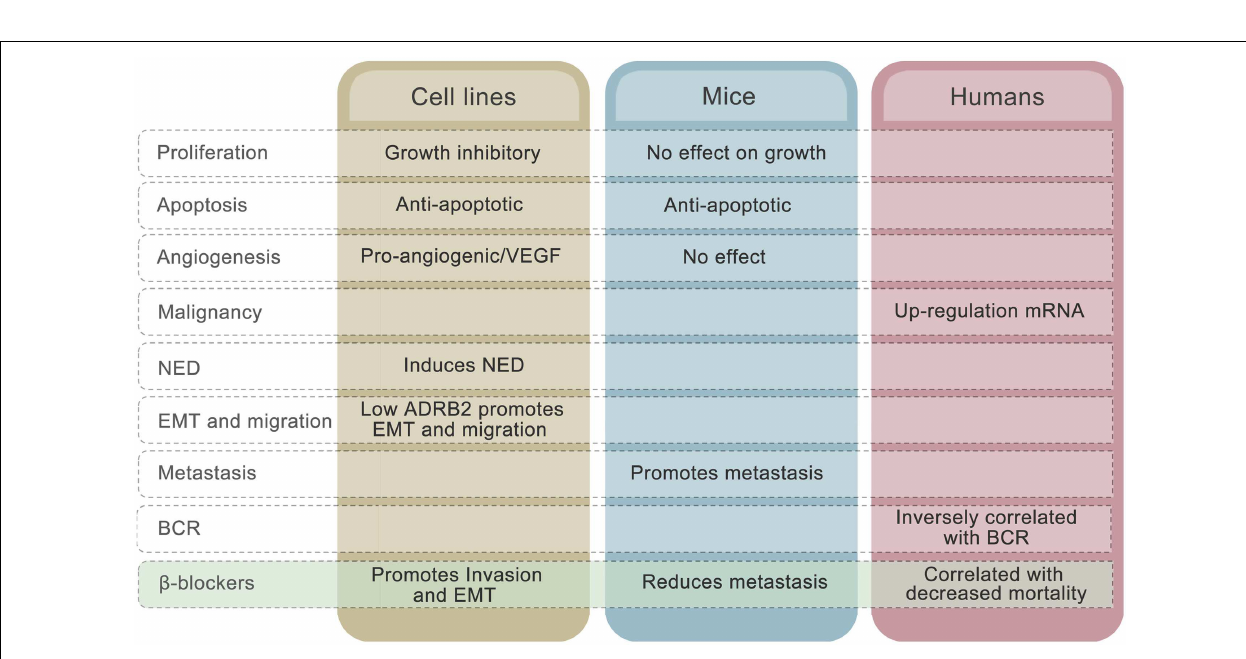
FIGURE 3 | Effects ofADRB2 on tumor characteristics in cell lines, mouse models, and human prostate cancer .The effects of β -blockers on the different characteristics in each model system is also shown.